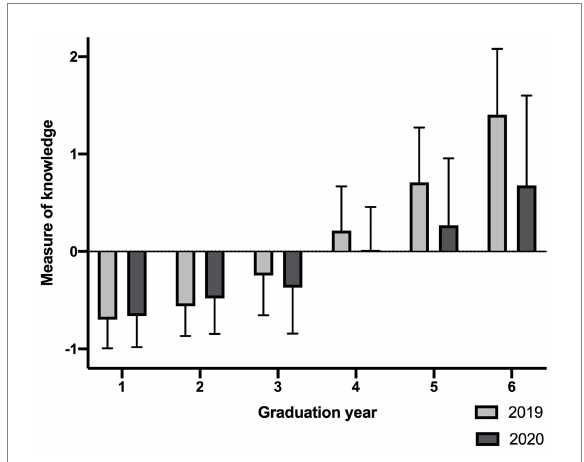
FIGURE 2 Curves of measure of knowledge for each graduation year. The mean scores of the students in the clerkship years are statistically lower in 2020 compared to